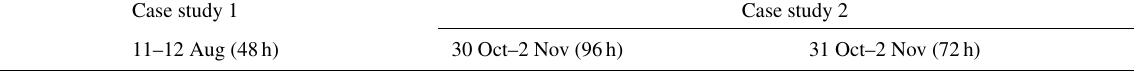
Table 5. Synoptic table summarizing the main findings for the different case studies. “Medsp” refers to Medspiration, “BC” refers to boundary conditions, “CP” refers to civil protection, and “DA” refers to data